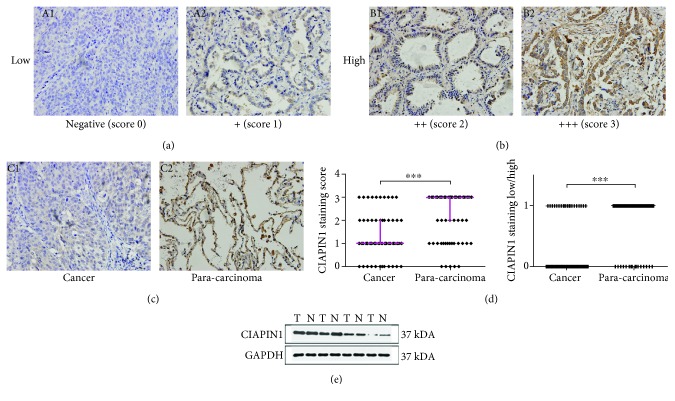
CIAPIN1 protein expression in NSCLC tissues and the matched noncancerous counterparts was detected. CIAPIN1 protein expressions were observed by immunohistochemical staining in 106 cases of NSCLC specimens. Representative photographs were taken at the magnification of 400x. (a) The immune scores 0 and 1 were defined as low CIAPIN1 expression. Representative photographs with low CIAPIN1 expression were shown. (b) The immune scores 2 and 3 were defined as high CIAPIN1 expression. Representative photographs with high CIAPIN1 expression were shown. Blue was marked as the nucleus, and brown was marked as the CIAPIN1 protein. (c) CIAPIN1 expression was relatively high in noncancerous tissues observed by immunohistochemical staining. (d) The CIAPIN1 staining score was statistically higher in matched noncancerous specimens compared with NSCLC samples (P < 0.001). (e) Western botting analysis was further performed to confirm the higher expression of CIAPIN1 in four matched benign tissues compared with cancer tissues. ∗∗∗P < 0.001, compared with control.